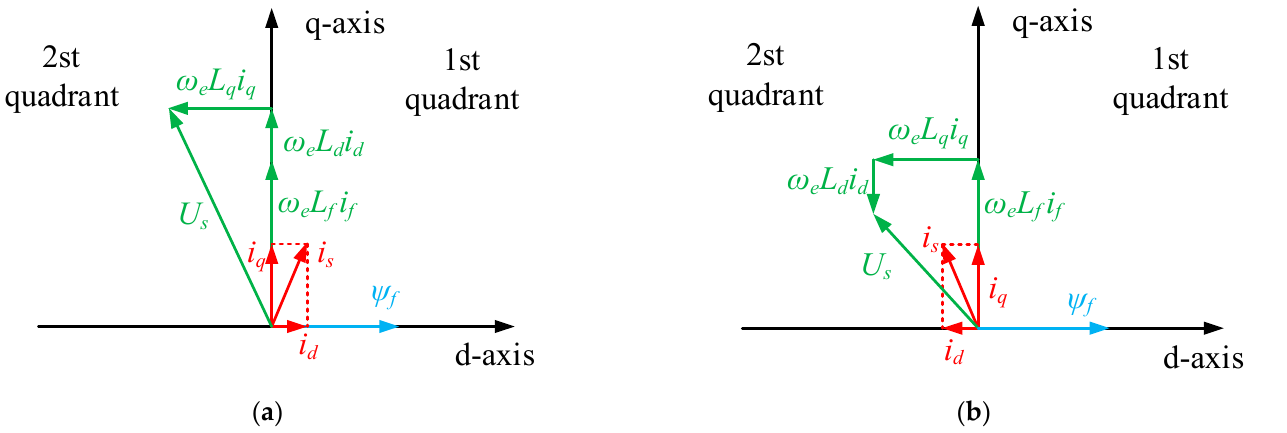
Figure 13. Vector diagrams of the 1st and 2nd quadrant operation: ( a ) 1st quadrant operation; ( b ) 2nd quadrant operation.